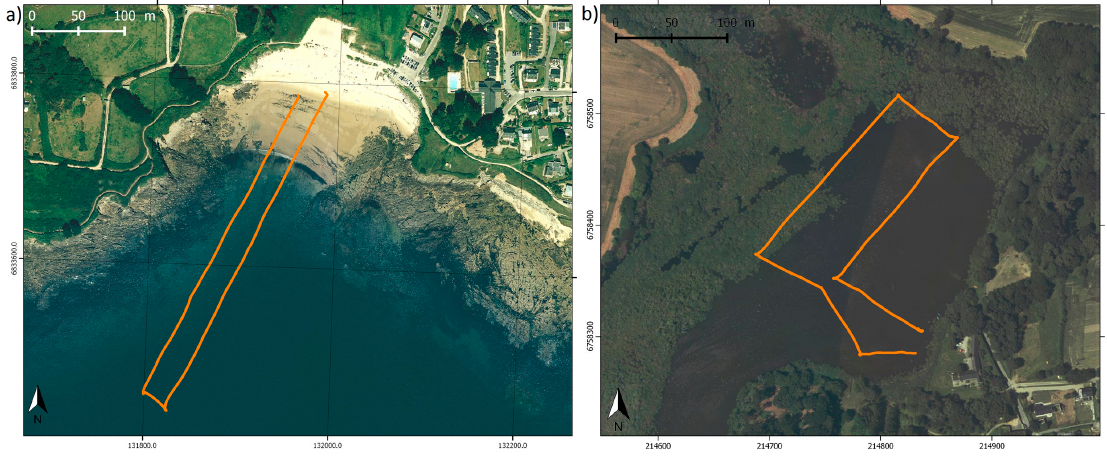
Figure 6. Flight lines followed by the UAV ( a ) with a flight altitude of 50 m at Porsmilin Beach (Figure 5a,b) and ( b ) with a flight altitude of 100 m at Lannénec pond (Figure 5a,c). Table 2. Settings of the surveys at Porsmilin Beach and Lannénec Pond.